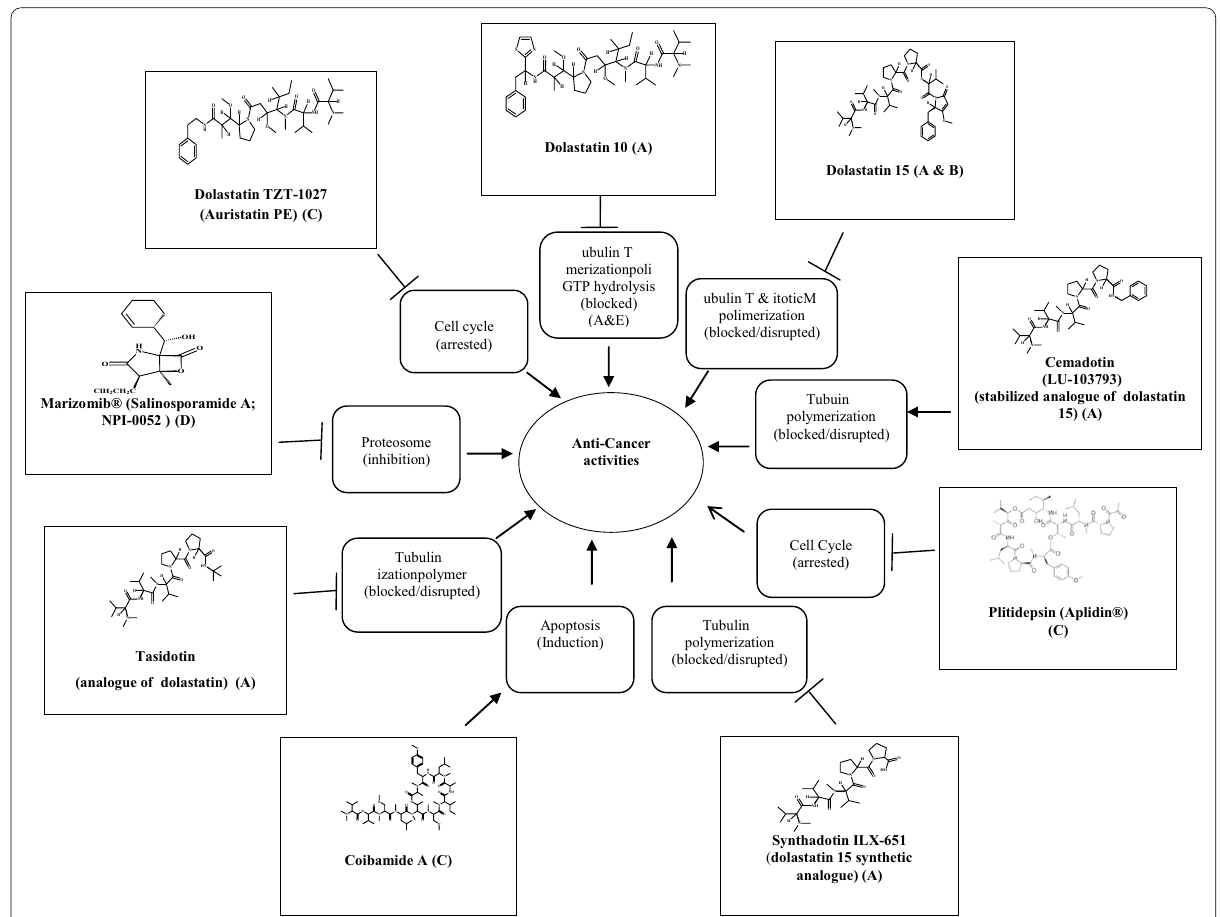
Fig. 5 Overview of the structures of representative marine pipeline compounds with their differential anticancer properties exhibiting various intracellular signaling pathways and molecular mechanisms to their biological targets. a and e Some compounds that inhibit the activity of microtubules and disrupting tubular polymerization, b some compounds that inhibit mitosis, c some compounds that interfere with the cell cycle and d some compounds exhibit proteasome inhibitory activity. e Some compounds inhibit GTP hydrolysis activity. Major molecular targets of marine compounds known to modulate different hallmarks of cancer by inducing apoptosis. Most of cell death hallmarks that have a mechanism involving microtubules inhibition and cell cycle arrest to induce